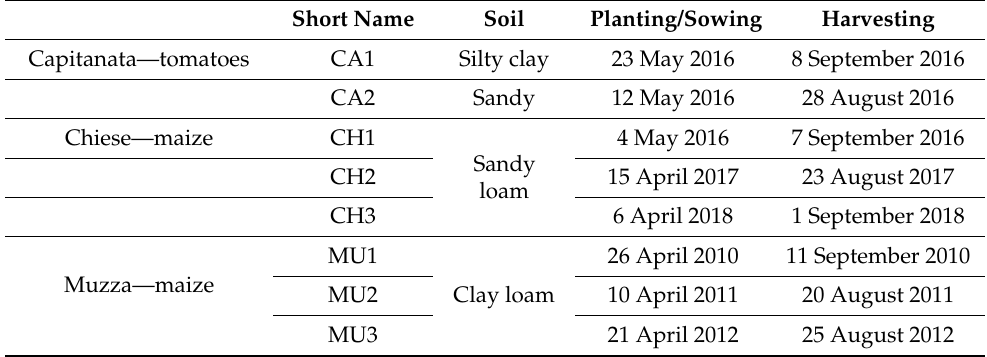
Table 1. Case studies fields, with soil type, planting/sowing and harvesting dates, crop type. Short Name Soil Planting/Sowing Harvesting Capitanata—tomatoes